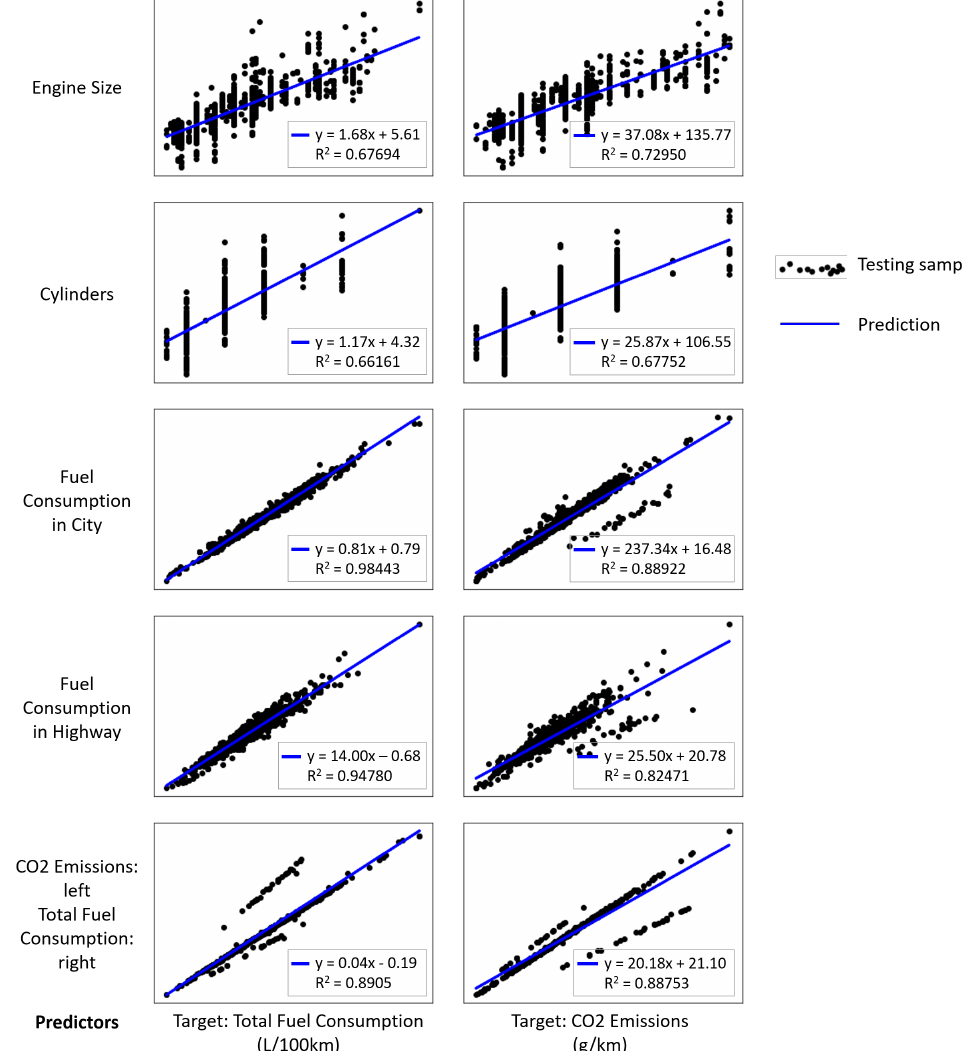
Figure 18. Scatterplot of prediction outputs of Linear Regression model in different